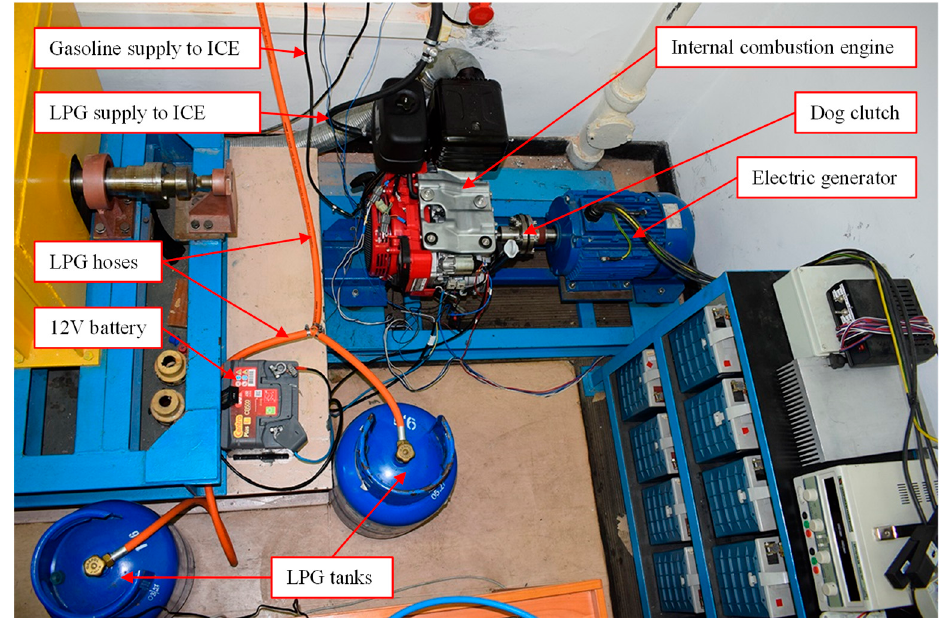
Figure 3. Laboratory test stand: general view of the combustion engine, generator, and a part of the LPG supply system.